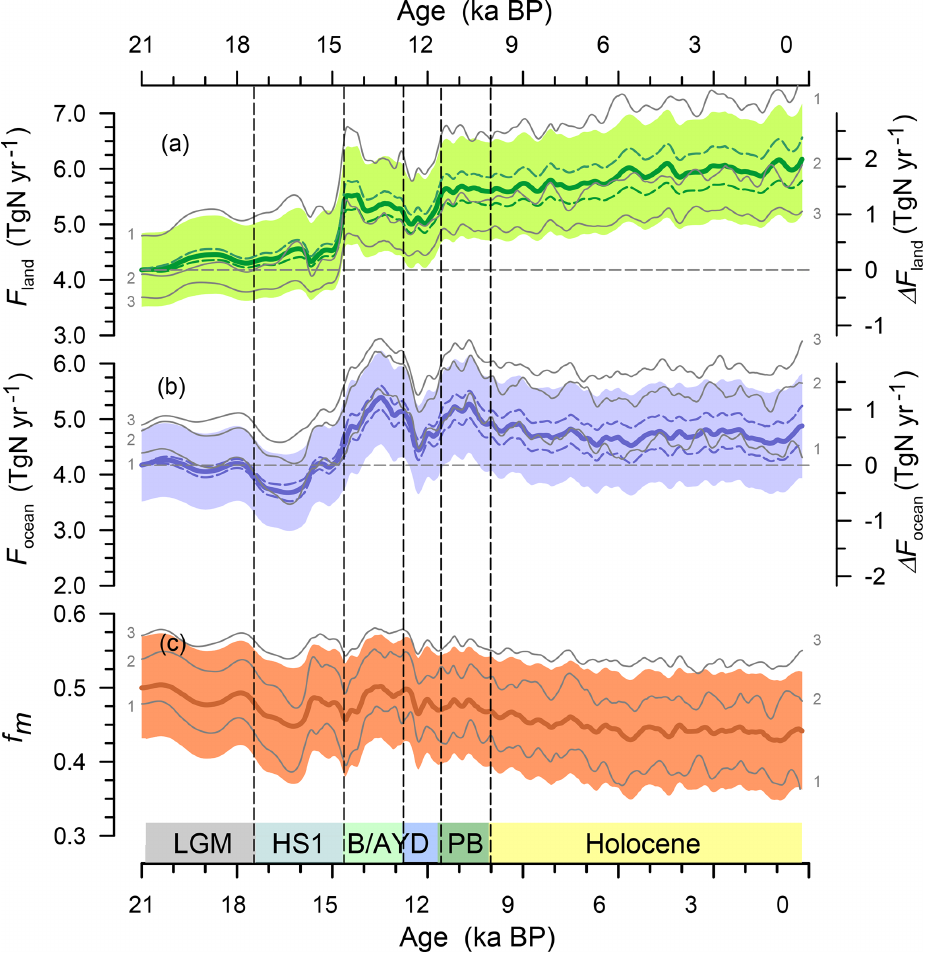
Figure 7. Reconstructed global terrestrial (a) and marine (b) N 2 O emission changes: mean reconstructed terrestrial and marine N 2 O emis- sions are shown by the solid green and blue lines, respectively, together with their uncertainty estimate ( ± 1 σ ; colored shaded area) based on 500 accepted runs calculated using the Monte Carlo atmospheric two-box model (Schilt et al., 2014) and ice records of N 2 O concentration and δ 15 N(N 2 O). (c) mean reconstructed marine fraction f m of total emissions (solid brown line) and its 1 σ uncertainty (orange shaded area). y axes on the left indicate reconstructed absolute emissions, y axes on the right indicate the terrestrial and marine emission anomalies relative to the LGM (21kaBP). The dashed colored lines around the mean anomalies indicate the ± 1 σ uncertainty of the reconstructed anomalies. Note that the uncertainties of the anomalies are smaller than those of the total fluxes, as the choice of the isotopic source signatures in the Monte Carlo approach systematically shifts total emission fluxes in an individual run to higher or lower values but not the anomalies. This is illustrated by three randomly selected runs (runs 1, 2, and 3, indicated by grey lines), which are systematically offset from each other in (a) – (c) . In summary, we are able to reconstruct anomalies in the N 2 O emissions relative to the LGM more precisely than the overall level of marine and terrestrial emissions using our